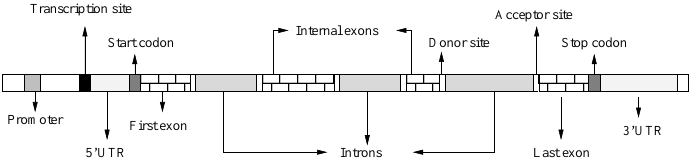
Figure 1: Simplified structure of a multi-exon eukaryotic